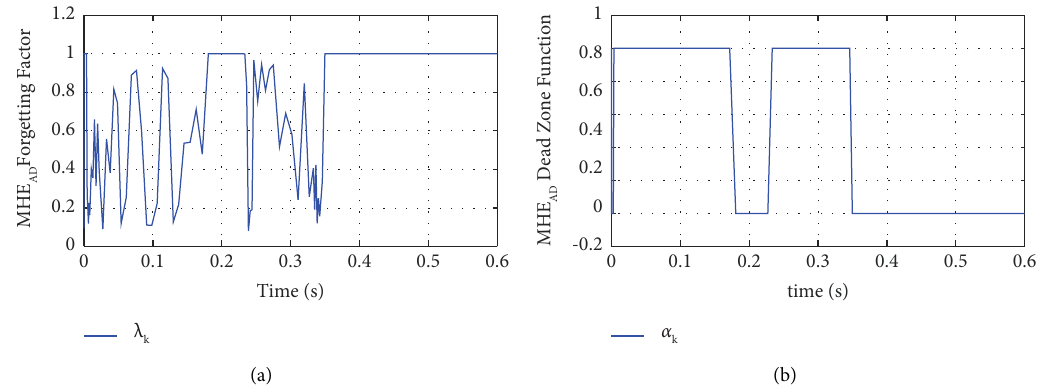
Figure 6: Evolution of the sequence of (a) forgetting factor and (b) dead zone